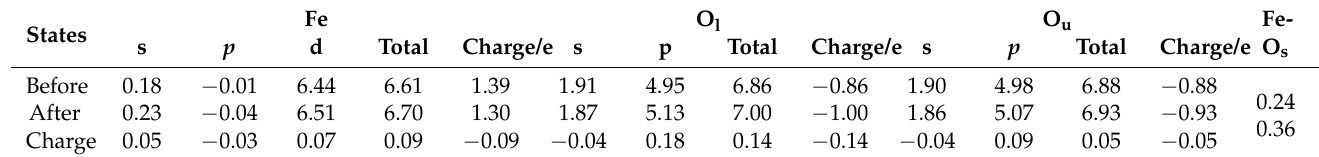
Table 8. Mulliken charge populations of bidentate adsorption, and Mulliken overlap populations of Fe-O s bonds.